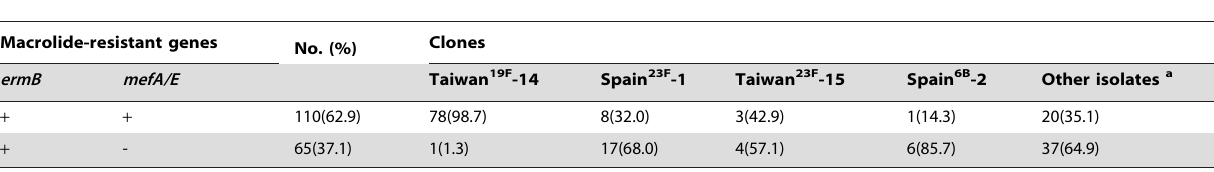
Table 4. The distribution of macrolide-resistant genes among 175 S.pneumoniae isolates in different clones.